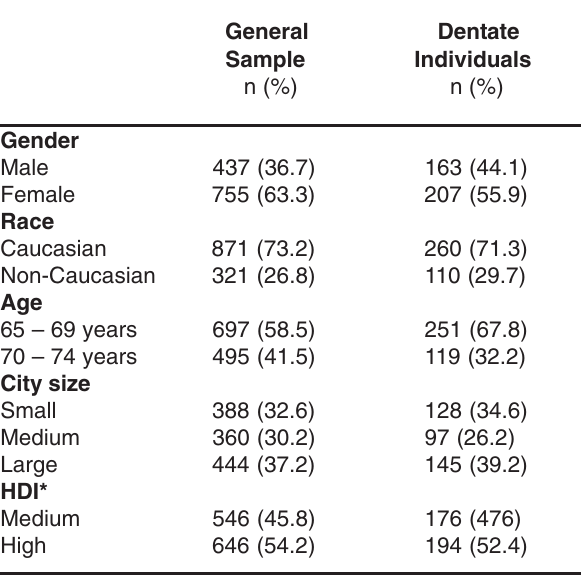
TABLE 1- Sample distribution according to gender, race, age, city size and HDI. Southern Region of the state of São